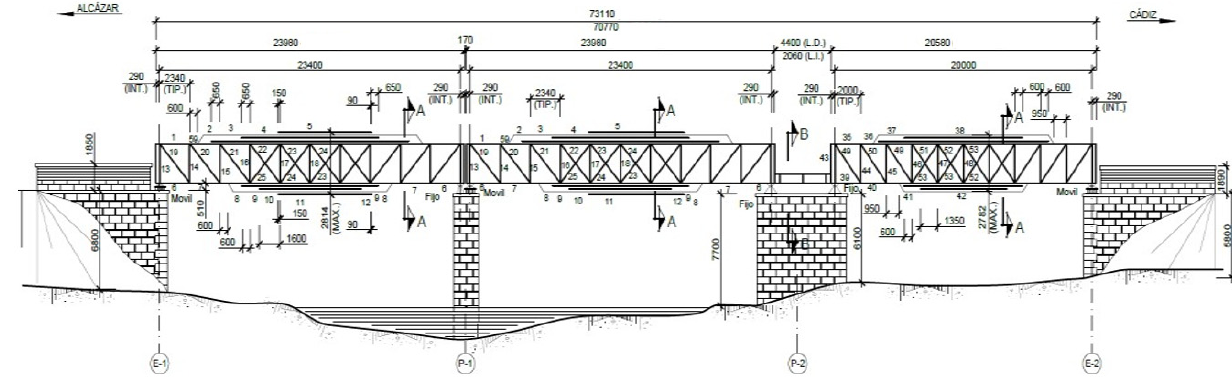
Figure 4. “Bembézar” elevation sketch (Dimensions in mm).